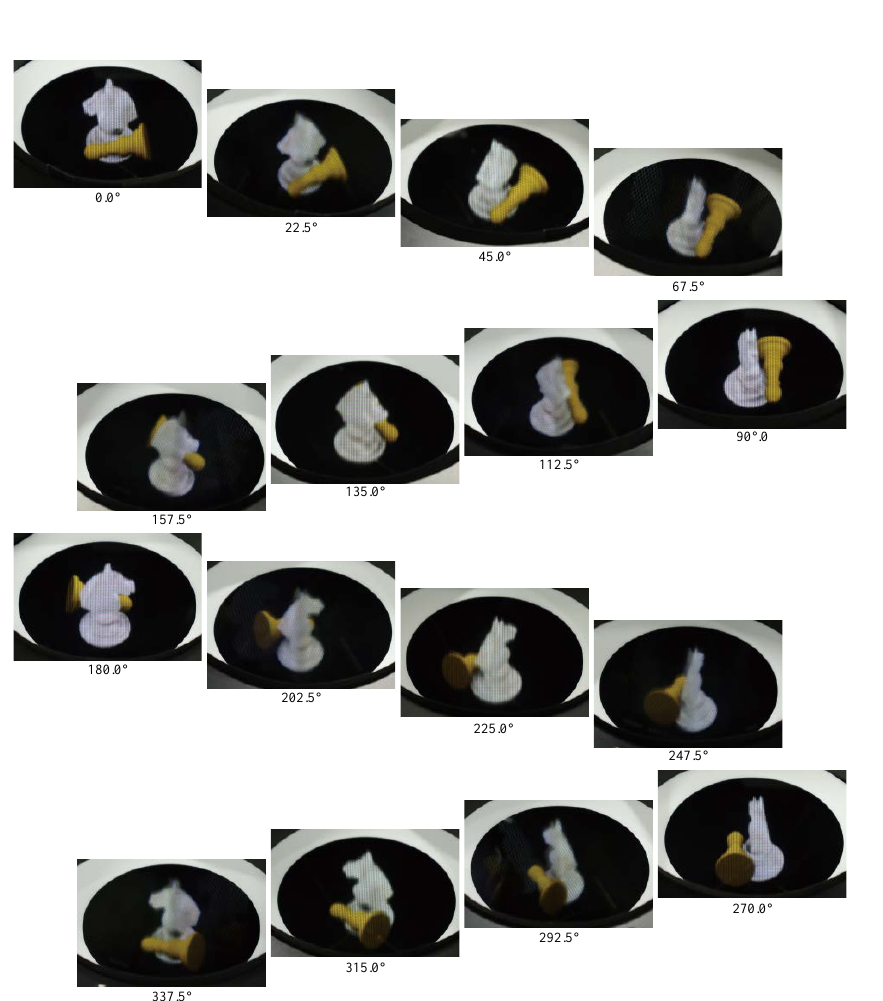
Figure 10. The 360-degree 3D image generated by tracking technique observed from 16 directions.